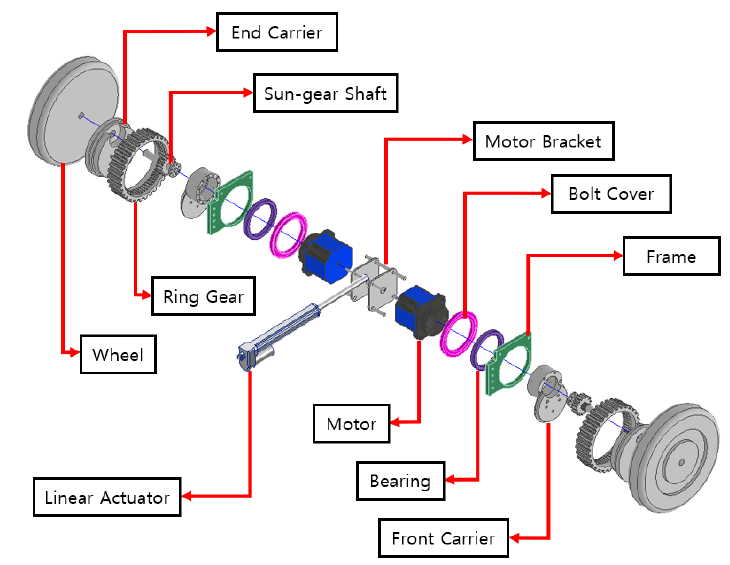
Figure 3. Exploded and cross-sectional view of the dual-speed transmission system .